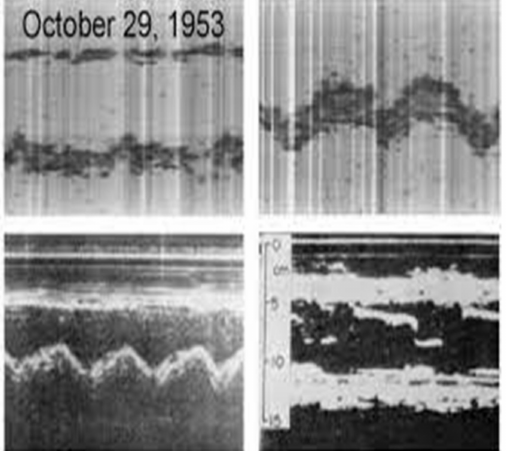
Figure 1. The first recorded ultrasound images of echocardiography from 29 October 1953 projecting in m-mode the walls of the left ventricle and the mitral